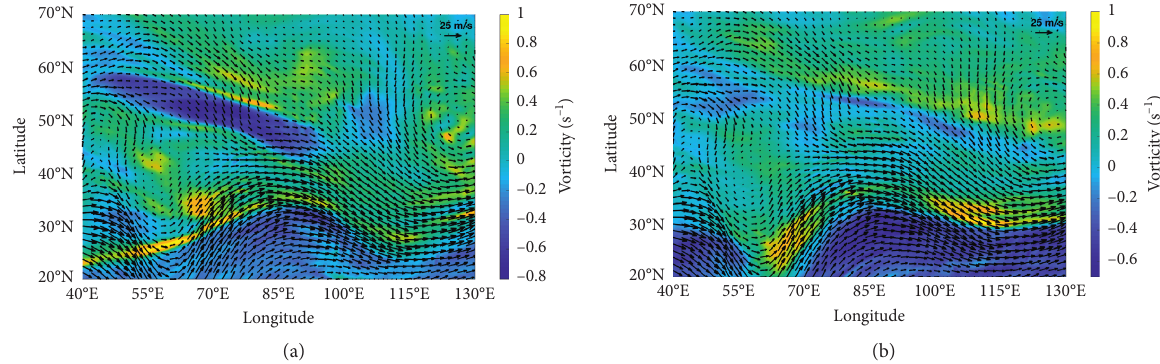
Figure 9: POD reconstruction of the 200hPa jet flow field (26 POD modes) at (a) T � 60h and (b) T � 124h (velocity visualized by vector plots and the background color contours visualize the vorticity component).